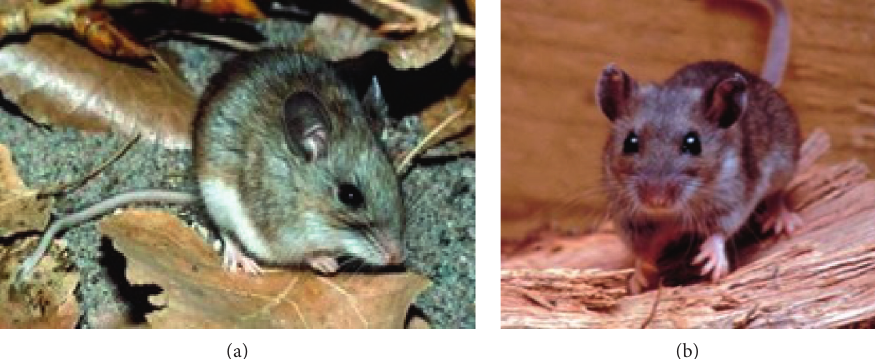
Figure 3: (a) Deer mouse [6]. (b) White-footed mouse